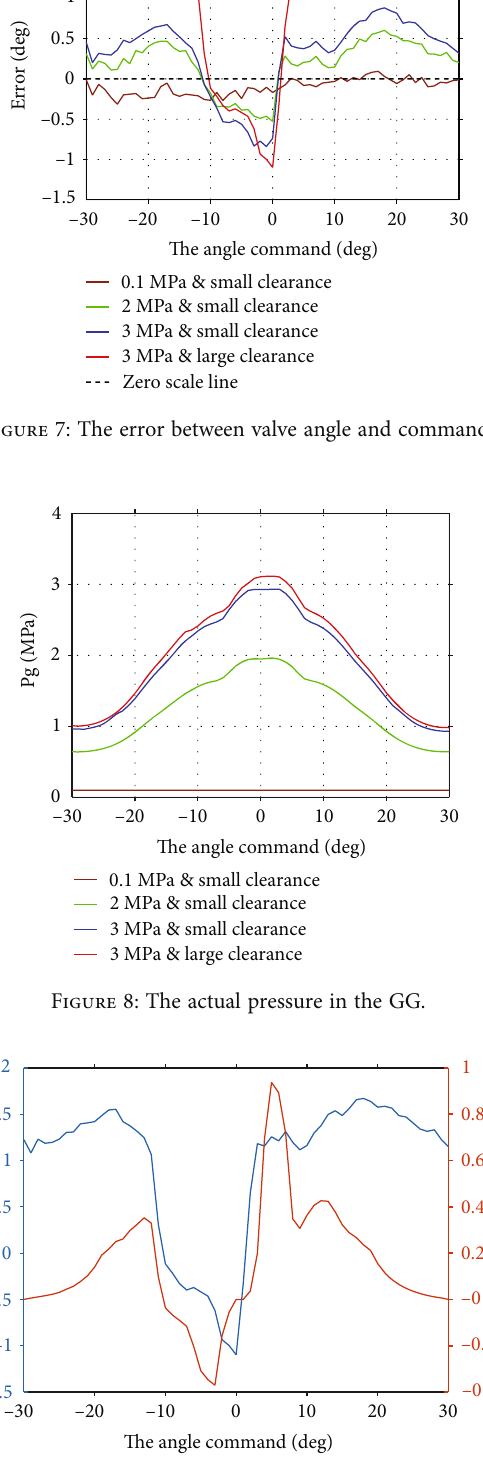
Figure 9: Pressure deviation under the condition of “ 3 MPa/large clearance ” .